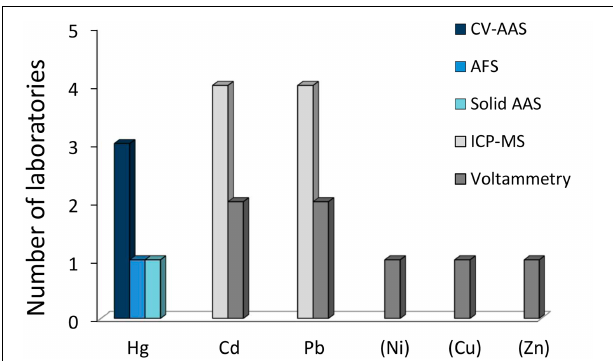
FIGURE 3 | Analytical methods used for metal analysis in seawater by different laboratories. CV-AAS, Cold Vapor Atomic Absorption Spectrometry; CV-AFS, Cold Vapor Atomic Fluorescence Spectrometry; Solid AAS, Solid Atomic Absorption Spectrometry; ICP-MS, Inductively Coupled Plasma Mass Spectrometry.